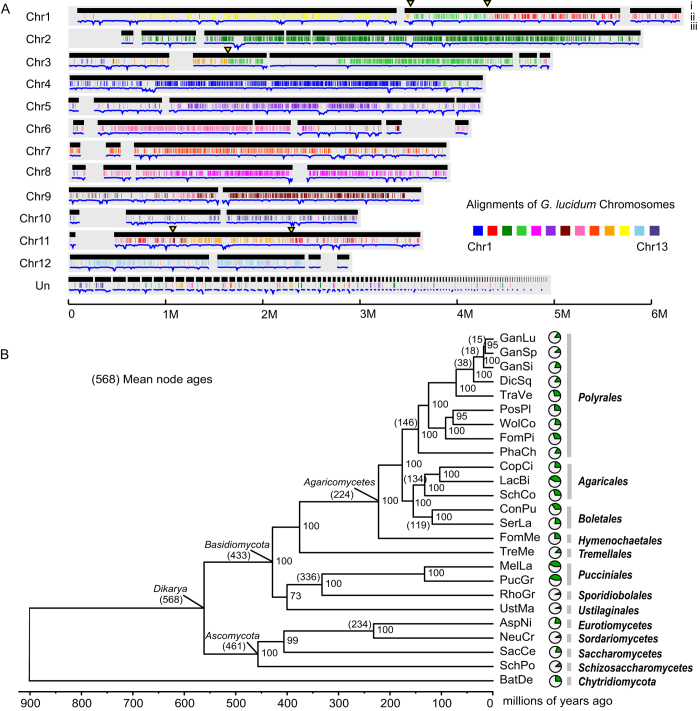
Genome comparison and phylogenetic relationships.A) The G. sinense genome was aligned, as the reference genome, with the G. lucidum genome. The grey background represents the 12 chromosomes. For each chromosome, row i represents the location of the G. sinense scaffolds on each chromosome, and row ii represents the fragments of the G. lucidum genome, which were mapped using MUMmer. The breakpoints are labeled as yellow triangles. Row iii represents the distribution of the transposable elements. Chr, chromosome. B) Phylogenetic relationships of Ganoderma and other fungi. A concatenated alignment of 59 single copy genes from 25 fungi was used to construct a phylogenetic tree using the maximum likelihood method. The mean node age was labeled using parentheses. After each node, bootstrap values higher than 50 were marked. The pie graphs exhibit the proportion of paralogous genes for each species. Full name of species were shown in methods.